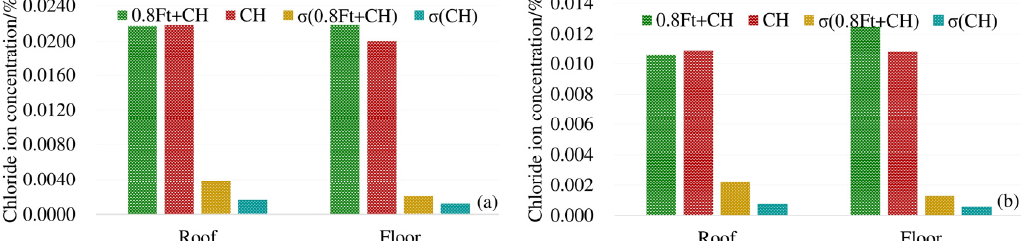
Figure 4. Average chloride concentration at different positions from the box girder surface: ( a ) 4 mm from the box girder surface; ( b ) 7 mm from the box girder surface.